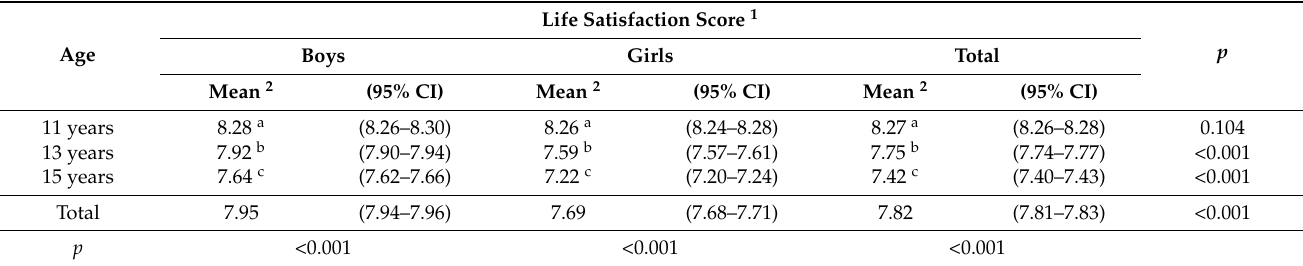
Table 4. Summary data on life satisfaction association with gender and age in adolescents from all 45